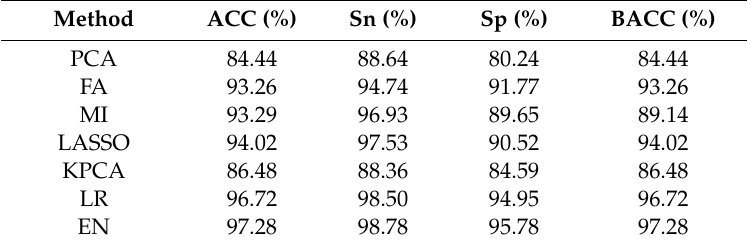
Table 8. Evaluation results of different dimension reduction methods.